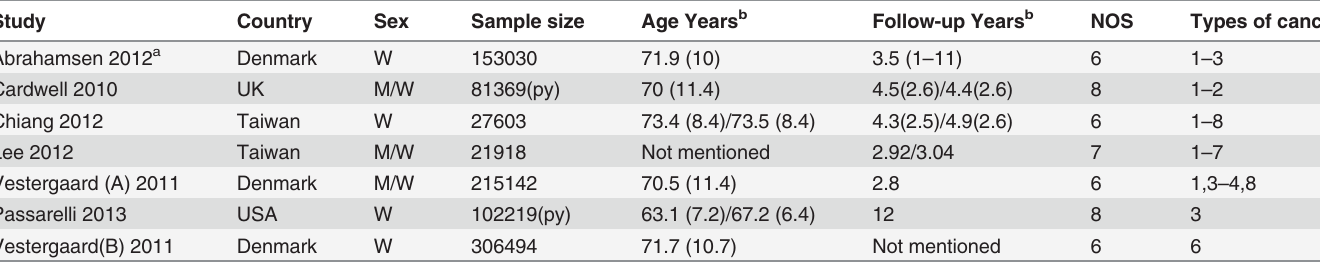
Table 1. Characteristics of studies included in meta-analysis.